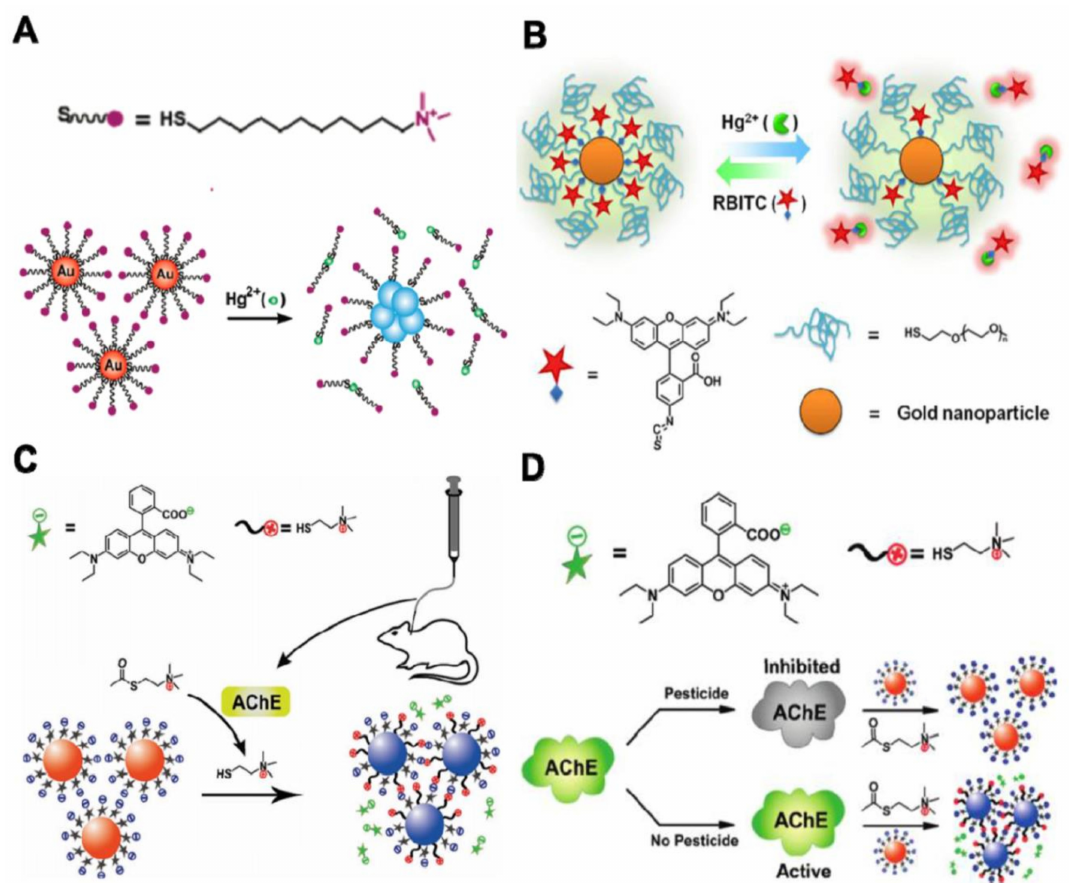
Figure 36. Ligand’s biodetection surface change exchange approach for Au NPs. ( A ) Au NPs for the Hg 2+ detection of ammonium quaternary group-capped. ( B ) Poly (ethylene glycol) (PEG)-comodified Au NPs for detection of Hg 2+ Rhodamine B isothiocyanate (RBITC). ( C ) Modification of the rhodamine B Au NP test in cerebrospinal fluid of transgenic mouse with Alzheimer’s disease in dual read-off acetylcholinesterase. ( D ) Dual readings for organophosphorus and carbamate pesticide detection in Rhodamin B-Au NPs. Adapted by reference permission [226]. Copyright 2012,